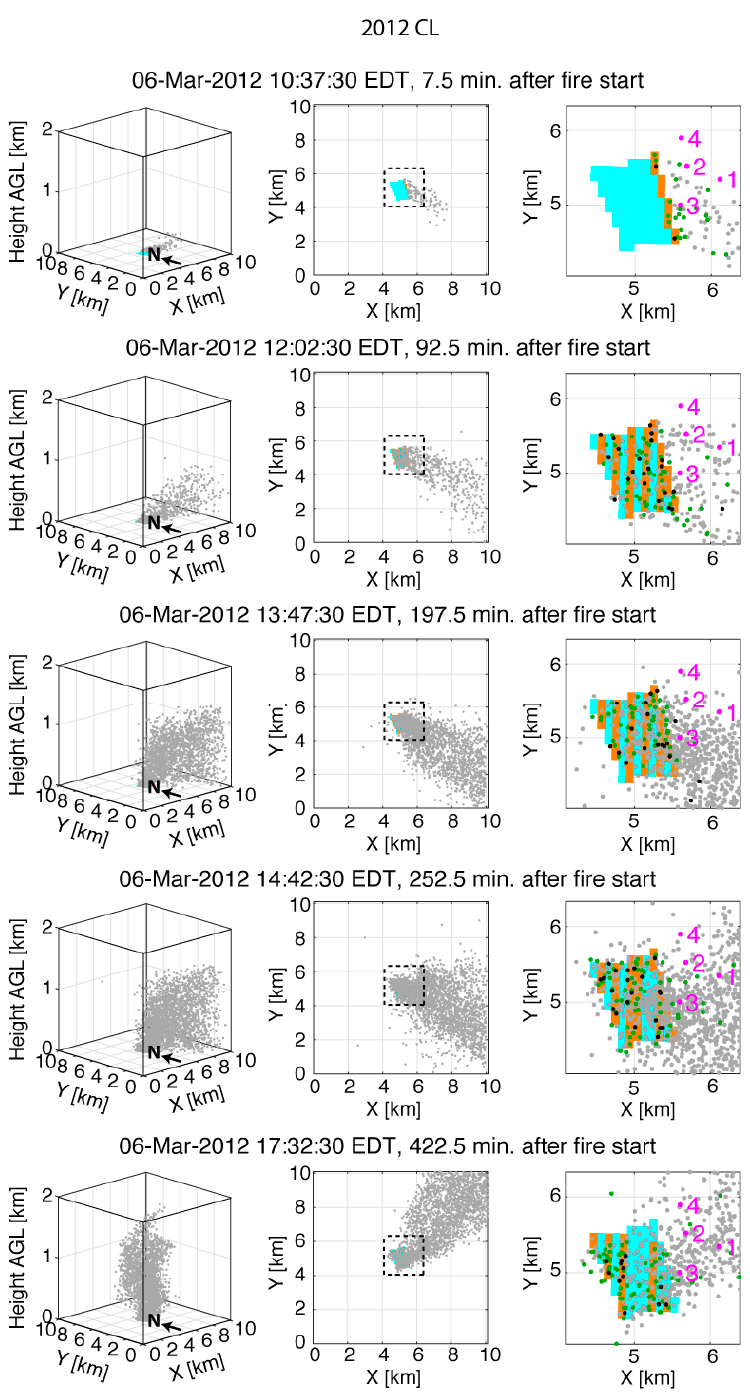
Figure 3. As in Figure 2, but for the 2012 control simulation (2012CL).